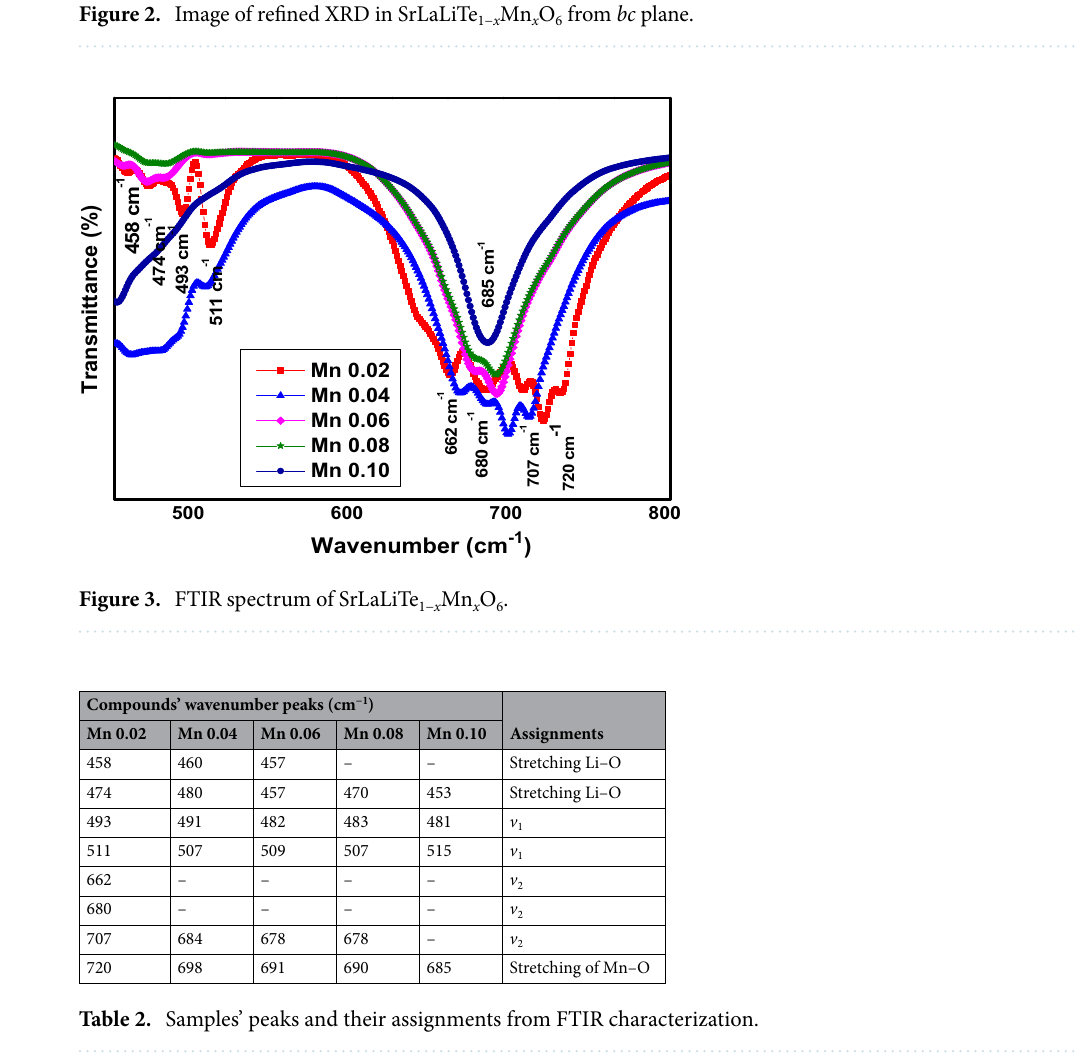
Figure 4 exhibits the morphology of SrLaLiTe 1− x Mn x O 6 ( x = 0.02, 0.04, 0.06, 0.08, and 0.10) compounds. The formation of agglomerated particles with same shape and size distribution of most grains were clear. The measured average grain sizes were increased from 1.03–1.97 µm, 1.10–1.17 µm, 1.97–2.07 µm, 2.14–2.26 µm and 1.21–1.43 µm as dopant concentration increased from x = 0.02 to x = 0.10. This variation trend was same with trend of crystallite size variation. The increasing trend of size of grain in Mn 0.04 to Mn 0.08 most prob- ably related to decrease in structural distortion when smaller ionic radius (Mn 6+ ) content increased 23 and thus, affecting rate of nucleation 42 . Other possible reason may be due to the reduction of grain boundaries energy